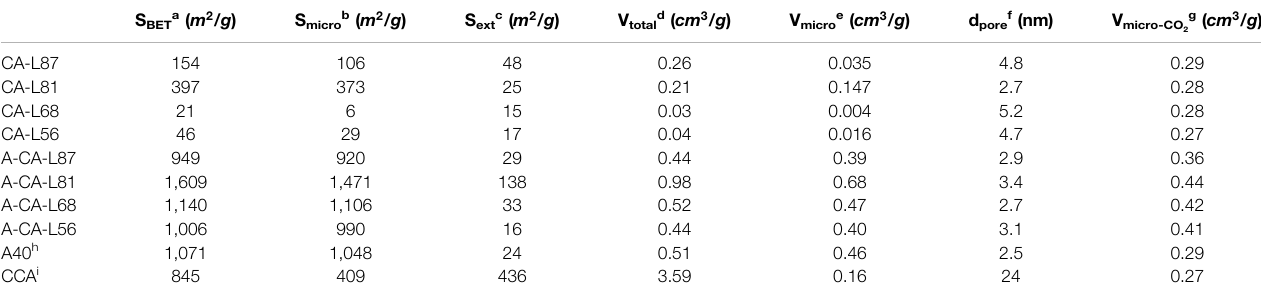
a Surface area calculated by BET method. b Surface area of micropores calculated by t-plot method. c External surface area calculated by t-plot method. d Total pore volume determined at p/po=0.99 relative